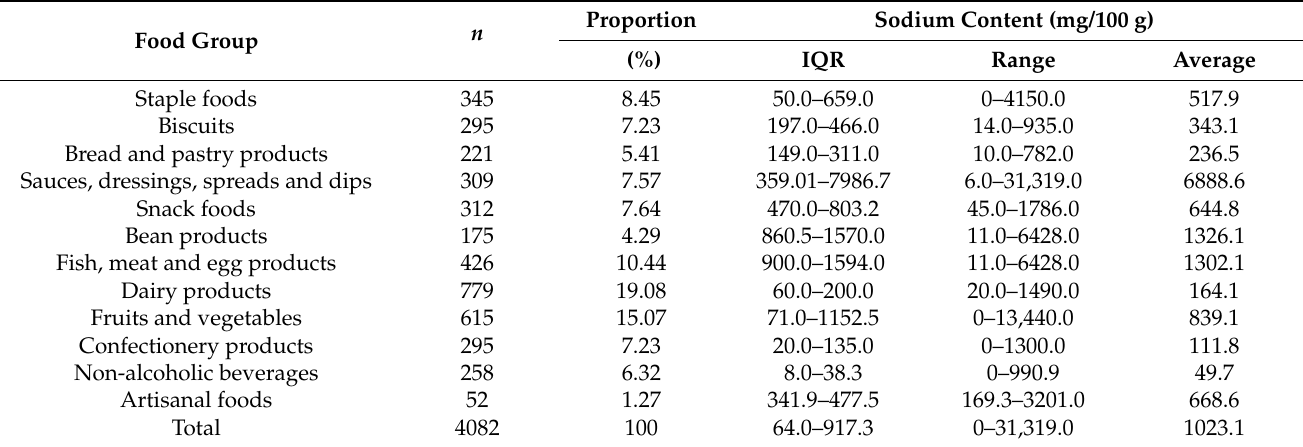
Table 1. The sodium content by group for commercial